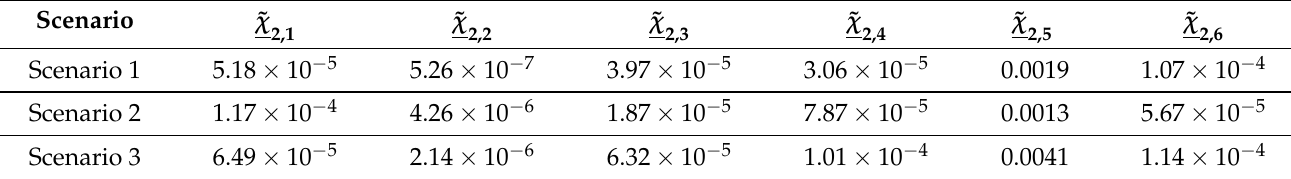
Table 3. Mean square errors of velocity estimates of the proposed approach at the steady-state